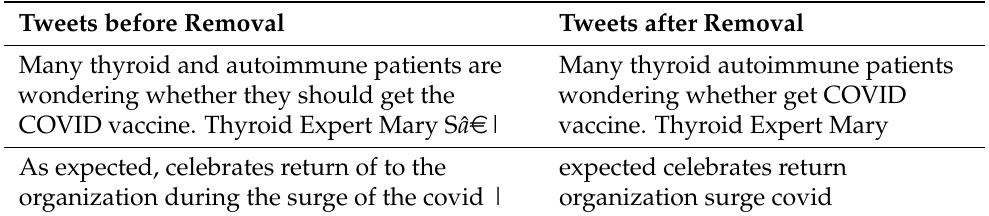
Table 3. Data after removal of numbers, punctuations, and stopwords. Tweets before